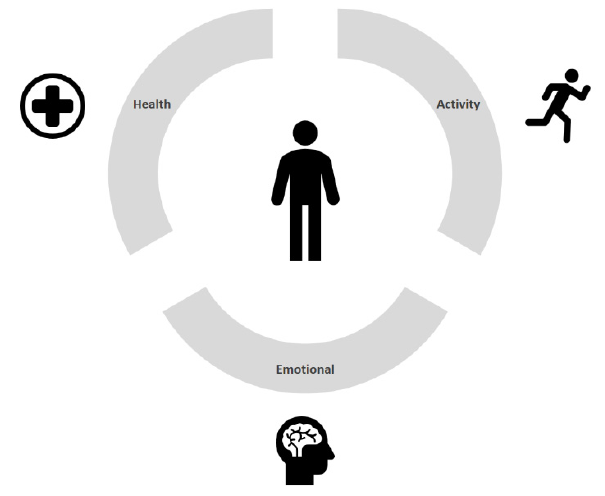
Figure 1. The three dimensions of well-being.